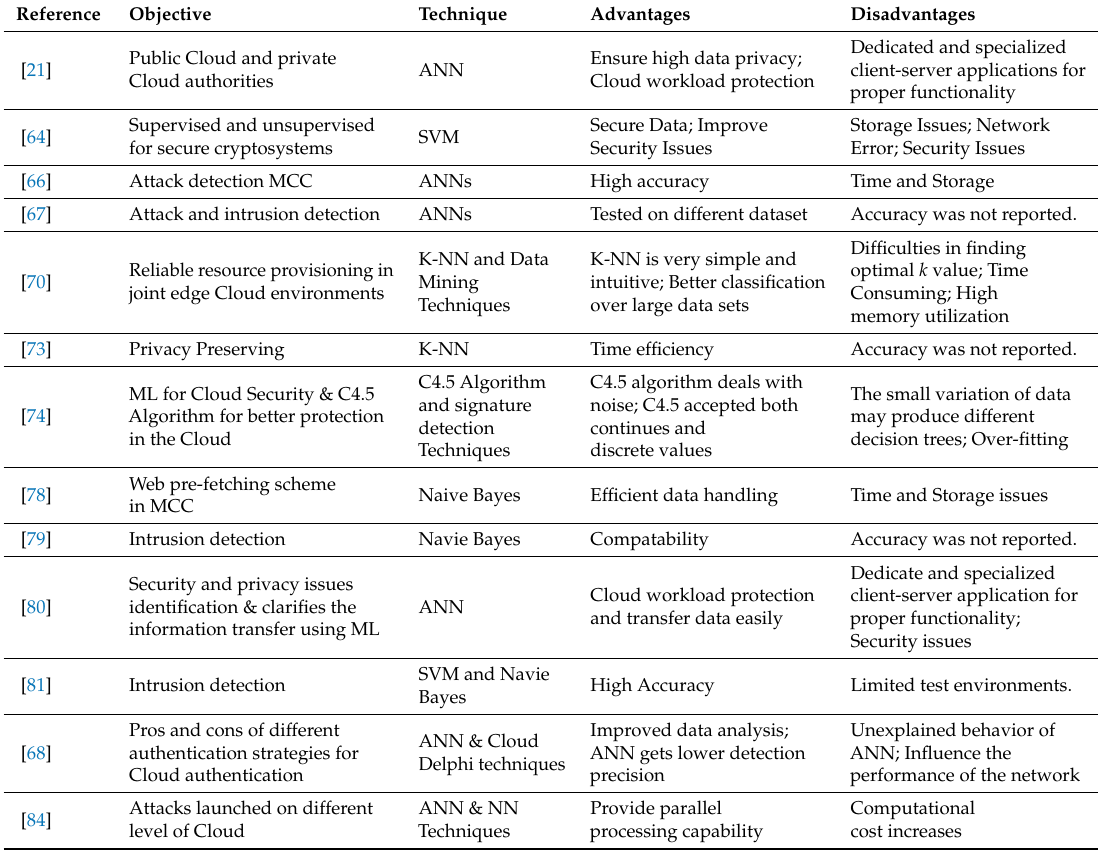
Table 3. Comparison of supervised learning techniques for cloud